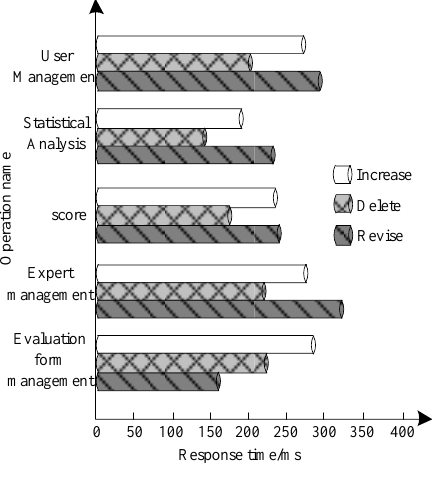
Fig 5. The proportion of teachers' professional titles in Fig 6. System operation